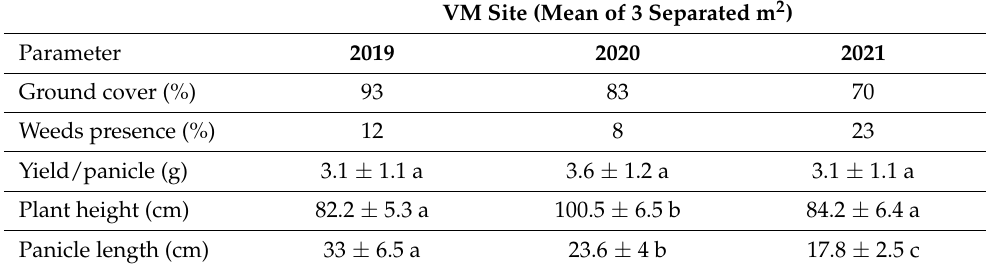
Figure 7. VM site open field proso millet in 2019 ( a ), 2020 ( b ), and 2021 ( c ) during the ripening stage (BBCH 7-8). Table 4. Agronomic parameters collected at the VM site, expressed as the mean of 3 separate sampling areas of 1 m 2 . For yield/panicle, plant height, and panicle length, formal statistical tests were performed. Different letters indicate significant differences ( p <